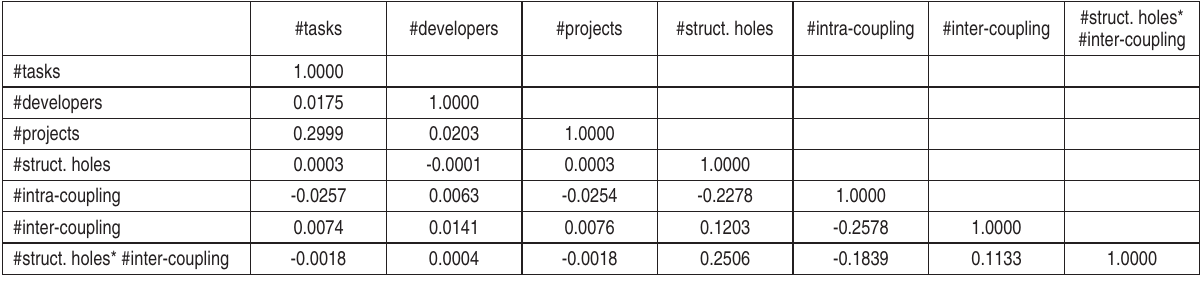
Table 6. Correlation matrix